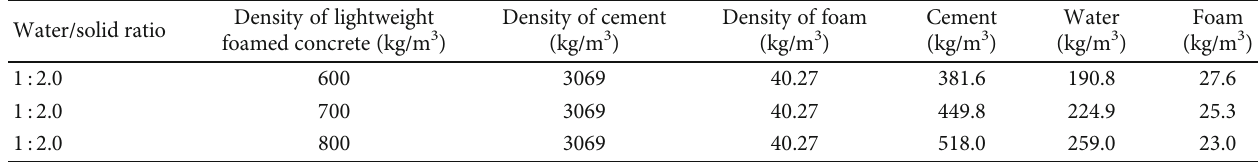
Table 3: The mix proportions of lightweight foamed concrete.